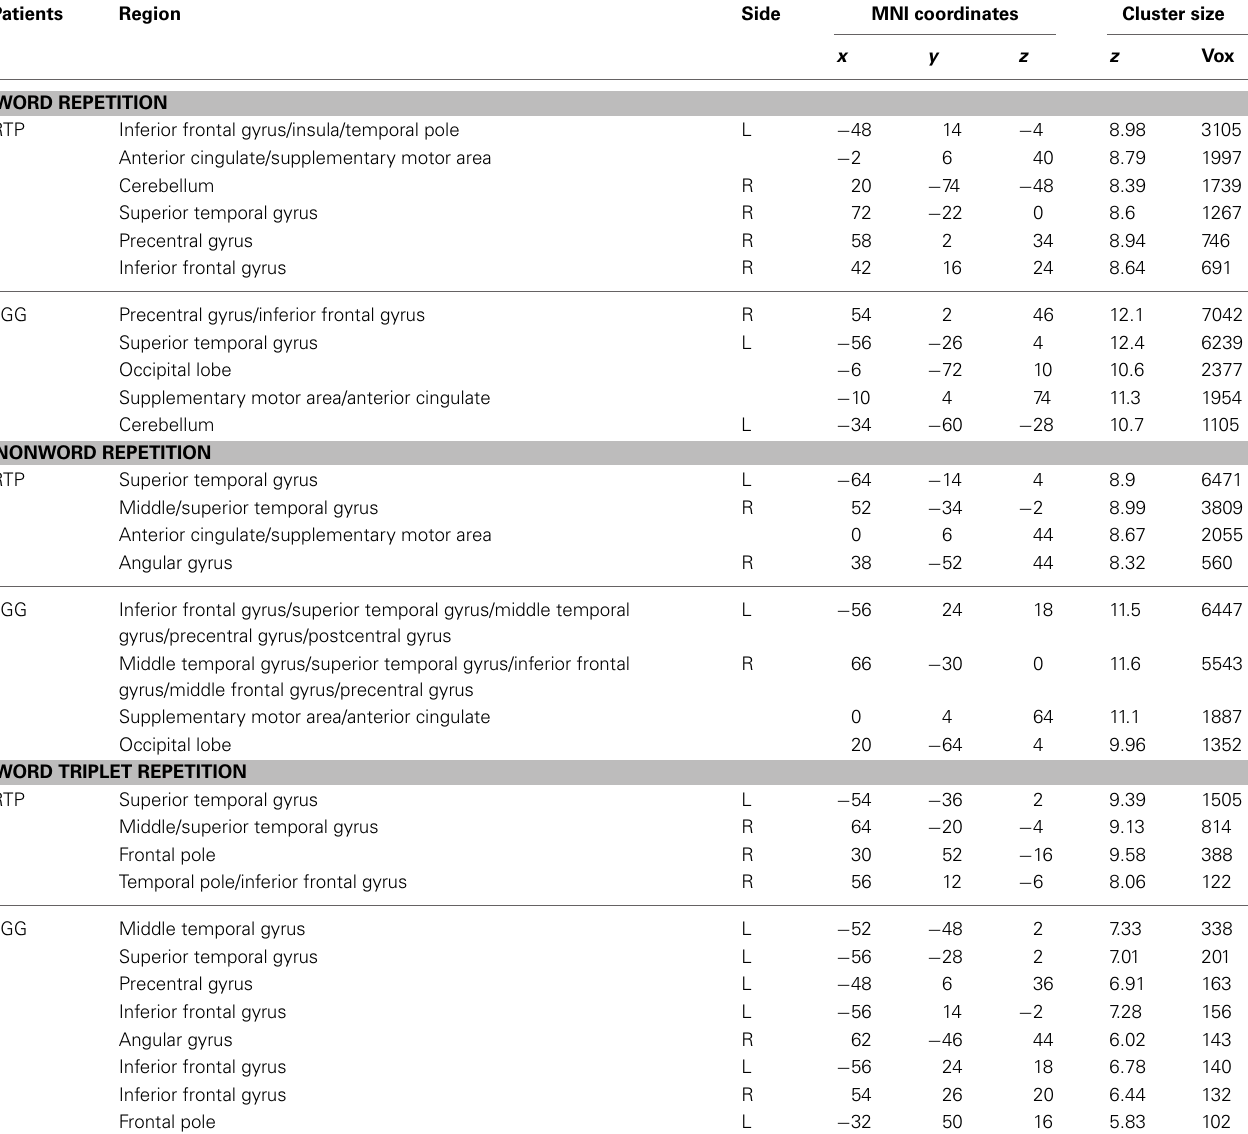
Table 3 | Brain areas activated on functional Magnetic Resonance Imaging during repetition tasks.